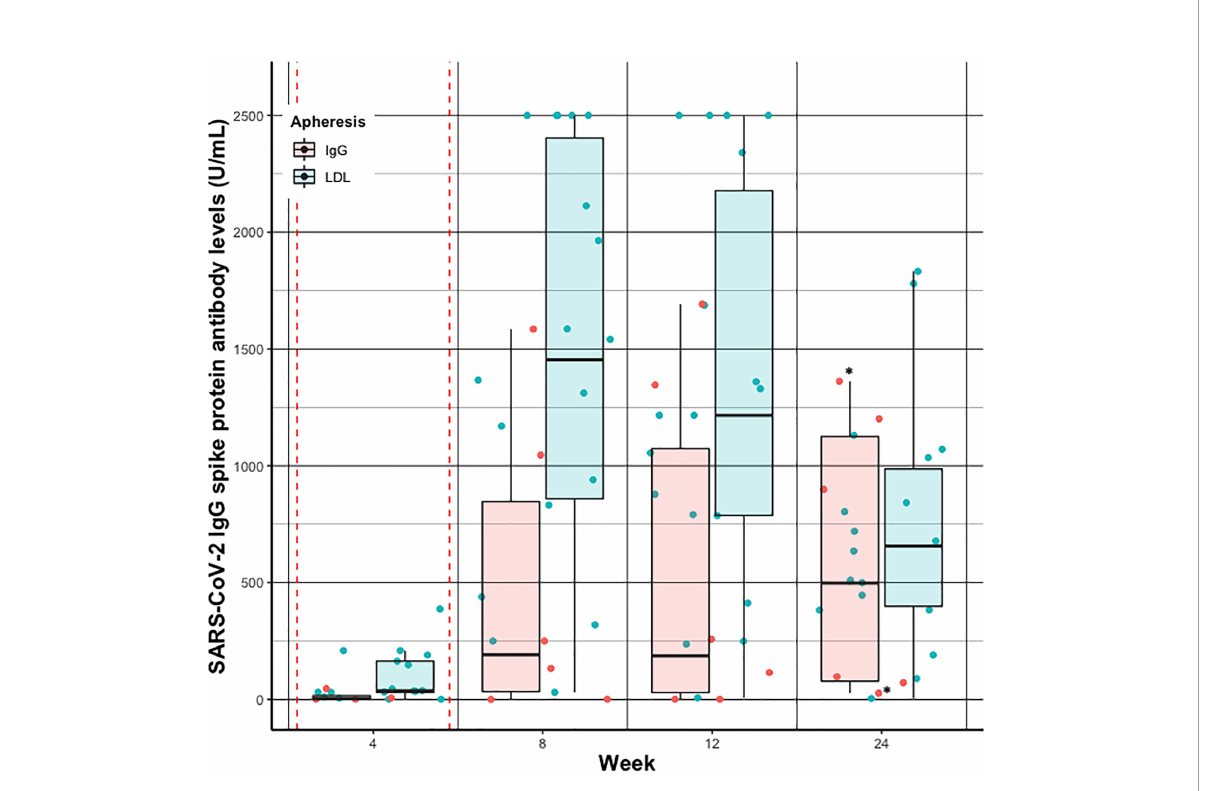
FIGURE 4 Individual (dots) and summarized (boxplots) SARS-CoV-2 IgG spike protein antibody levels before apheresis treatment at week 4, 8, 12, and 24 after vaccination in patients receiving IgG apheresis (red) and LDL apheresis (blue). Red dashed vertical lines indicate the fi rst and second vaccination, respectively. * indicates subjects who have received a 3 rd dose of the vaccine. For better visualization the geom_jitter function has been used to present individual SARS-CoV- 2 IgG spike protein antibody